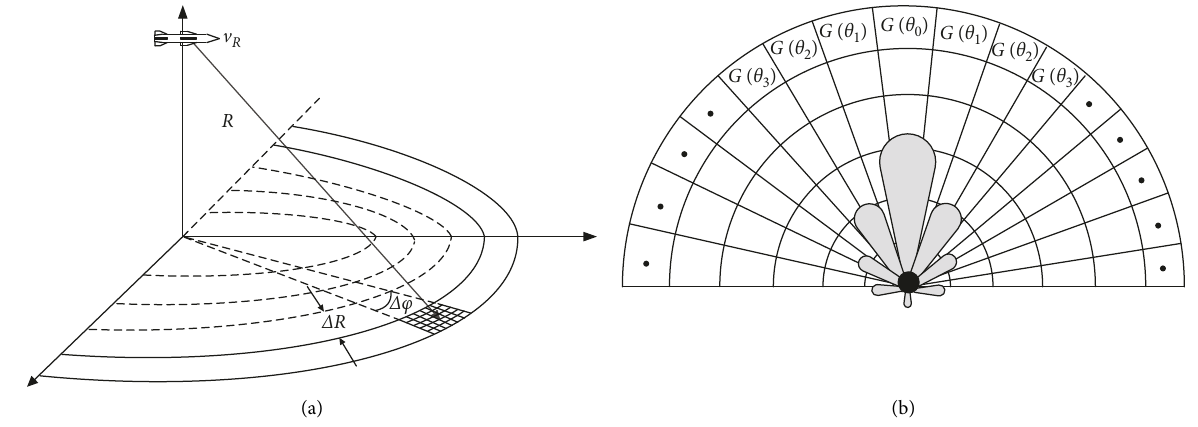
Figure 6: (a) Diagram of the Range-Doppler ring partition method; (b) top view.